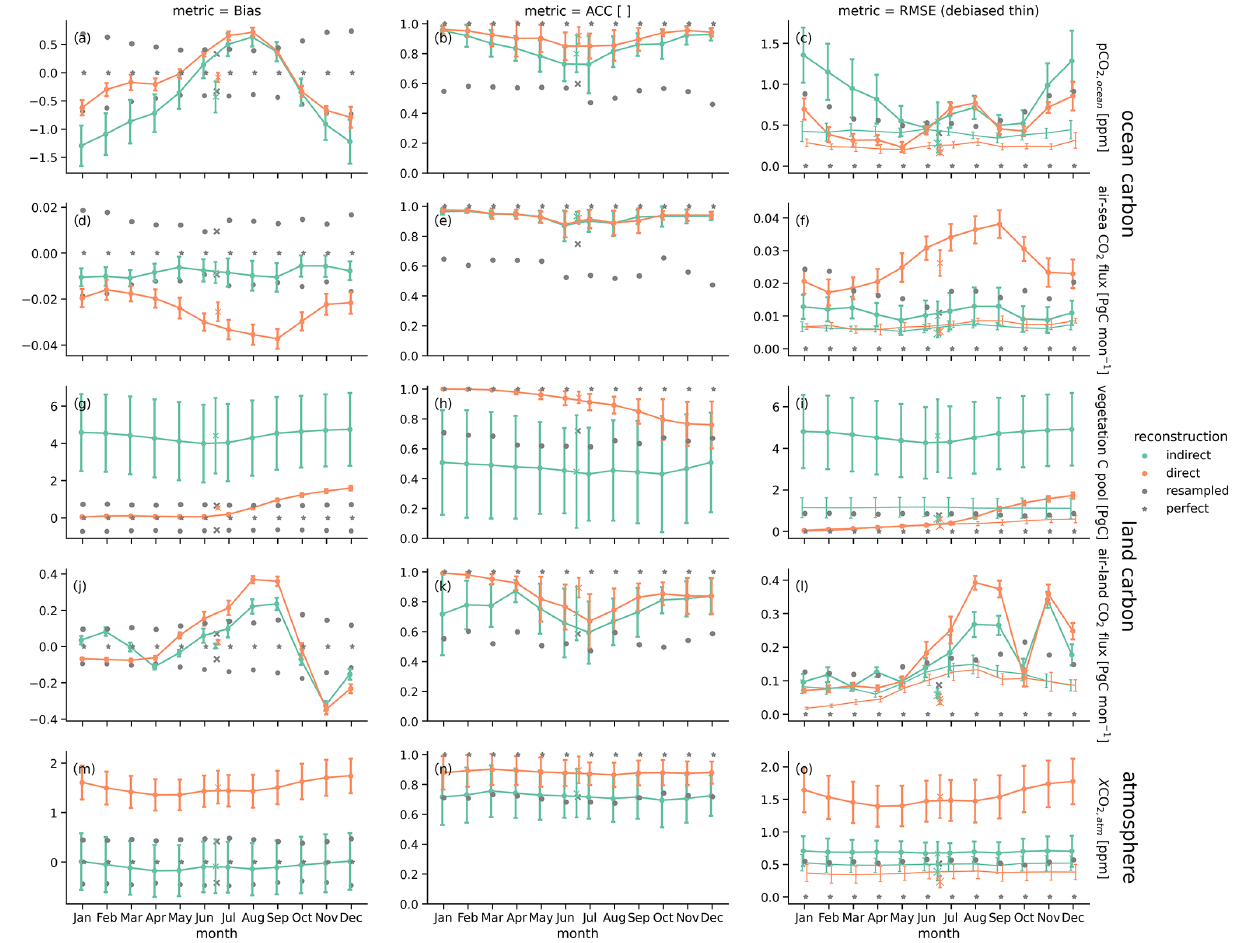
Figure C1. The 10-year running mean reconstruction skill per month in bias ( a , d , g , j and m ), anomaly correlation coefficient (ACC, b , e , h , k and n ) and root-mean-square error (RMSE, c , f , i , l and o ) for global aggregation of carbon cycle variables: (a–c) surface oceanic partial pressure of CO 2 , (d–f) air–sea CO 2 flux (negative values indicate carbon uptake by the ocean), (g–i) vegetation carbon pools, (j– l) air–land CO 2 flux (negative values indicate carbon uptake by land) and (m–o) mixing ratio of atmospheric CO 2 . Whiskers show the 5th and 95th percentile of the running skill over time. Colors show different reconstruction methods: indirect (green) and direct (orange). Gray stars indicate perfect skill. Gray dots mark the 95th percentile for ACC and 5th percentile for the remaining distance-based metrics of random reconstruction skill block-bootstrapped from the target control simulation as an unskilled reference skill. Crosses show reconstruction skill of annual mean time series. Thin lines show monthly RMSE skill after a mean bias